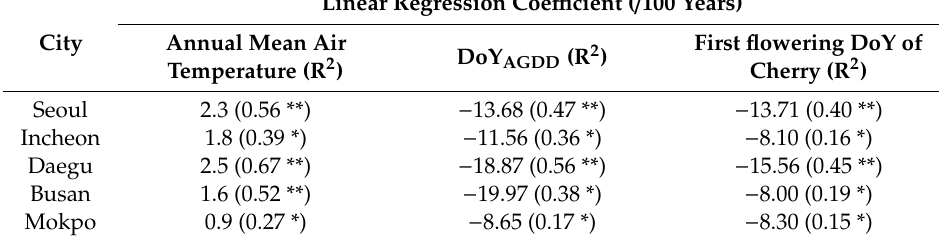
Table 2. The rate of change for the annual mean air temperature and the phenological event dates during the past